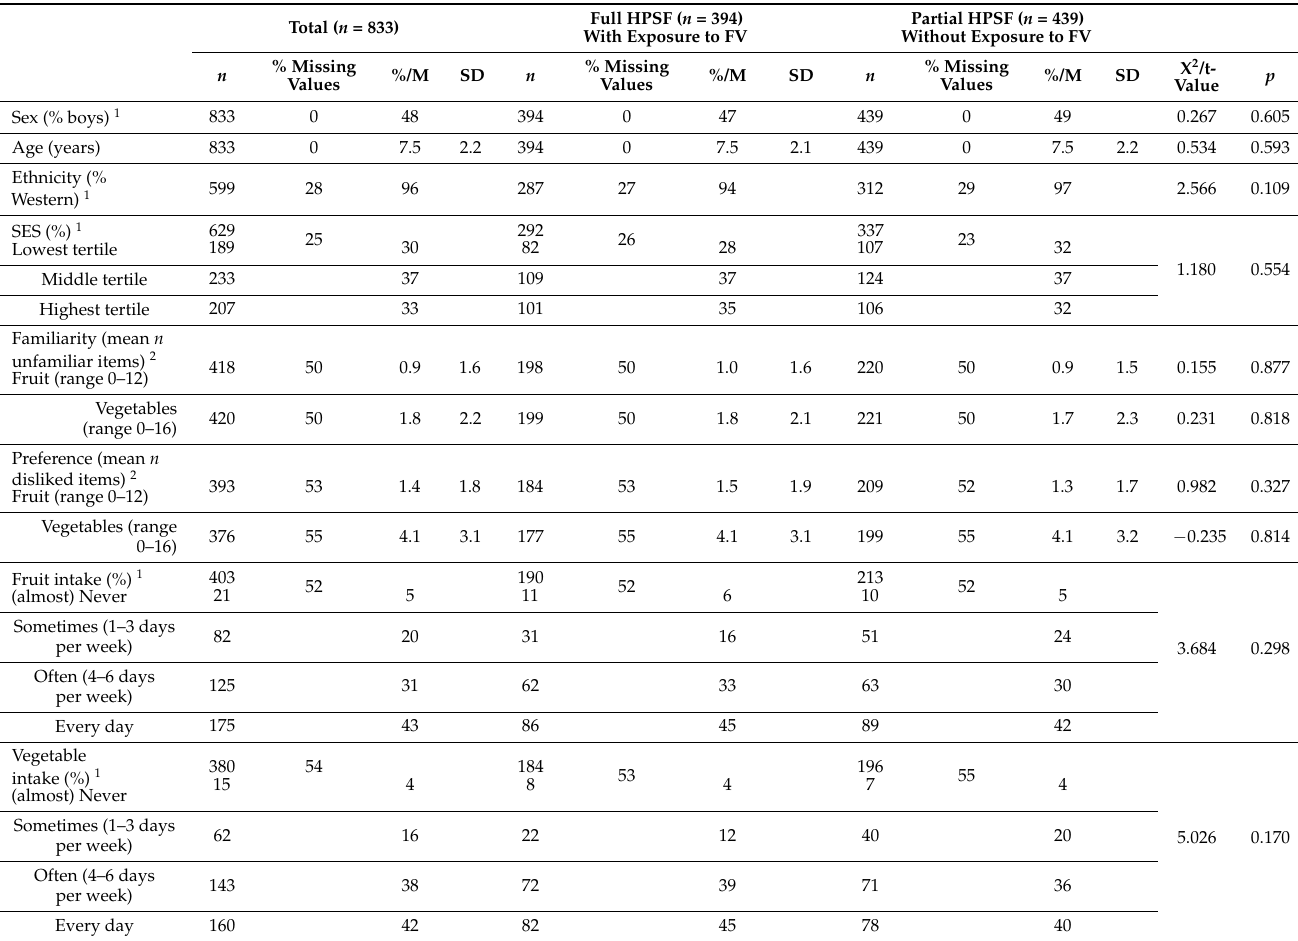
Table 3. Characteristics of participants at baseline